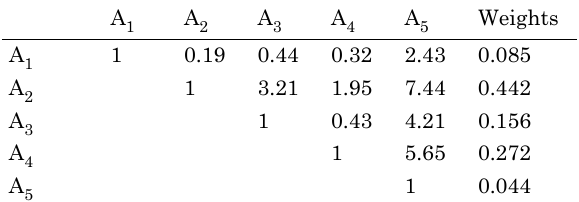
Table 9. Pairwise comparison judgment matrix of each type of exterior walls in the index of debris-removal